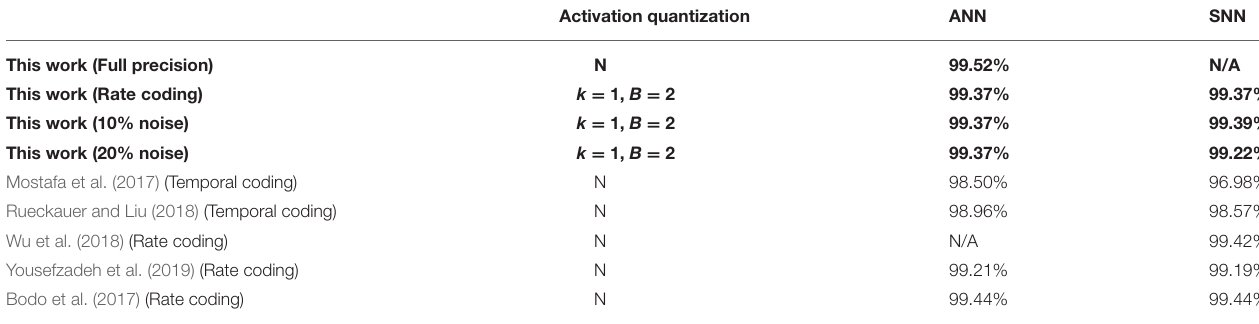
TABLE 4 | Classification accuracy on MNIST.